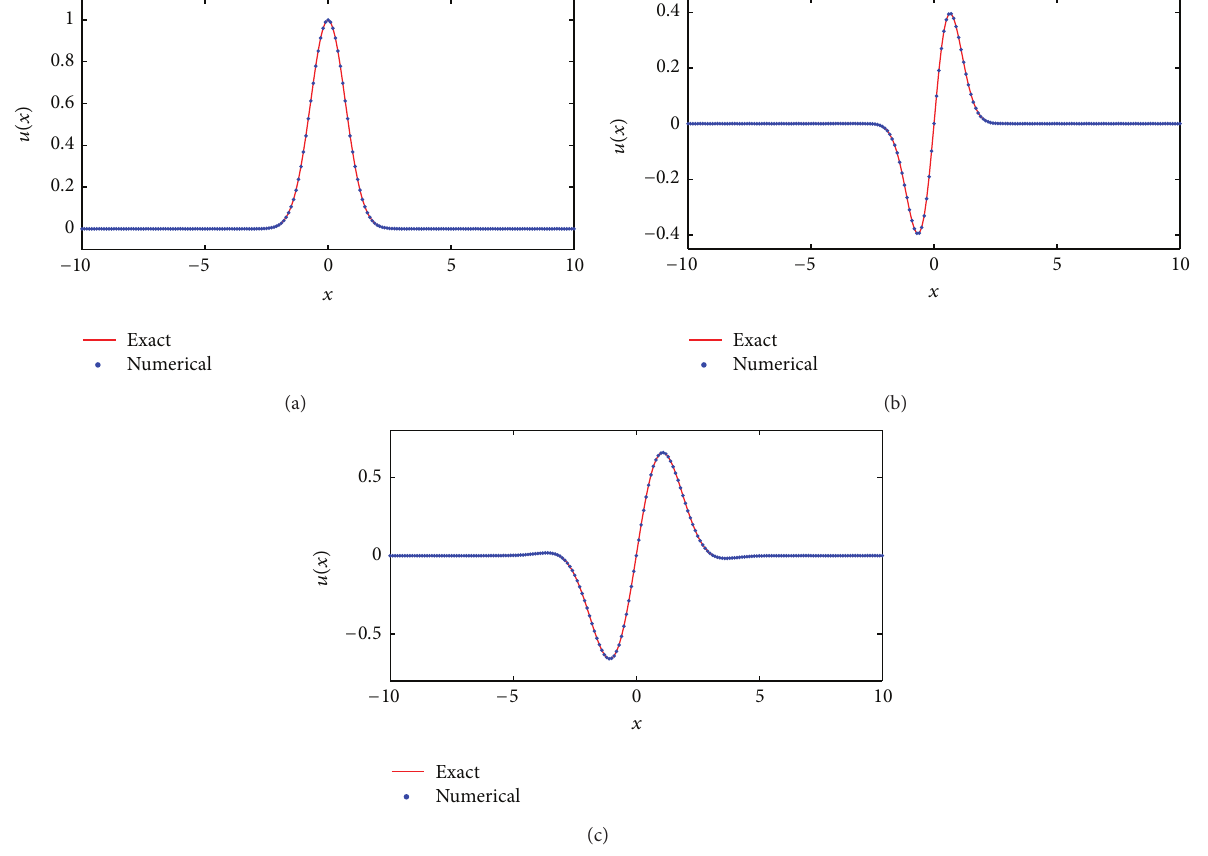
Figure 5: Numerical solutions compared to the exact